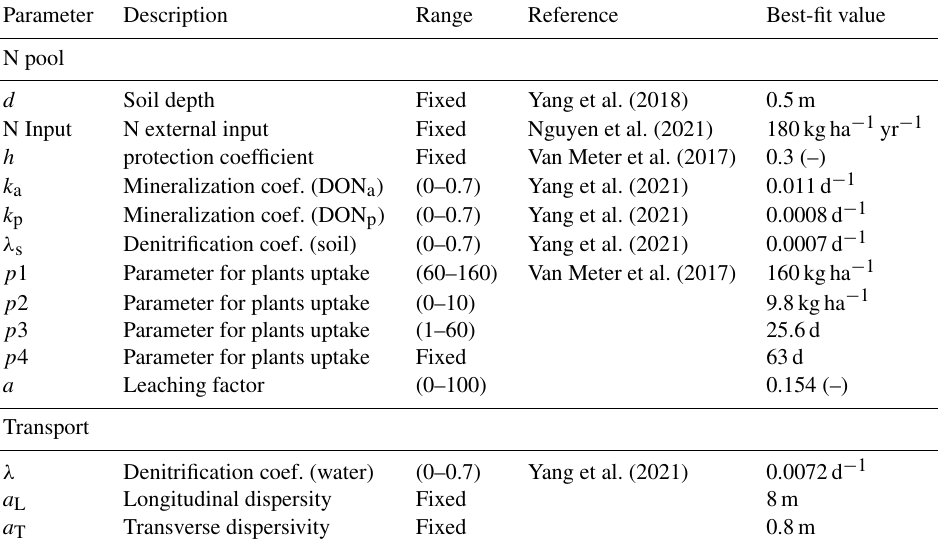
Table 2. The parameters for the N pool and nitrate transport. The parameters with a range are calibrated. The adjustable ranges are selected to cover the values that the parameters can potentially take on or the values reported by the referred literature.